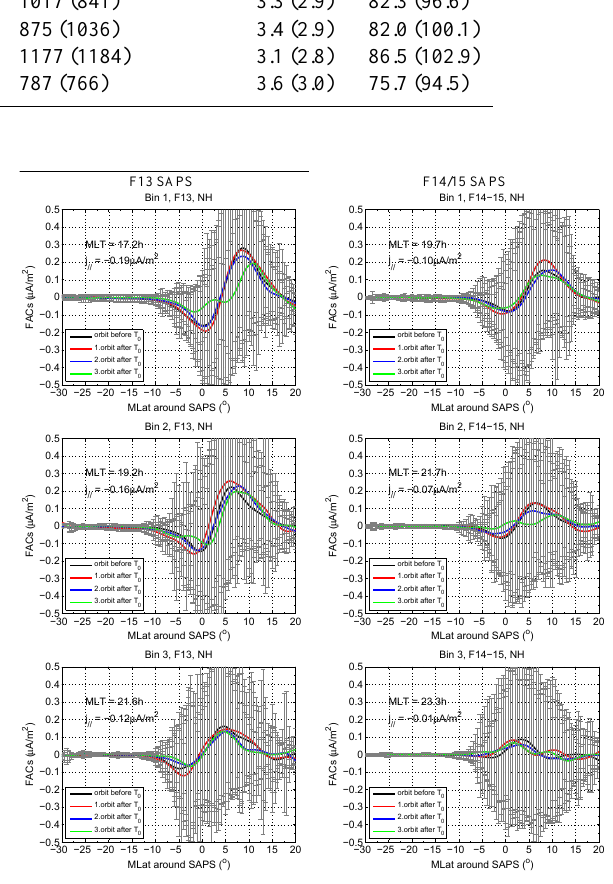
Fig.3. SuperposedepochanalysisoflargescaleFACsineachbinforDMSPF13andF14/15. Figure 3. Superposed epoch analysis of large-scale FACs in each bin for DMSP F13 and